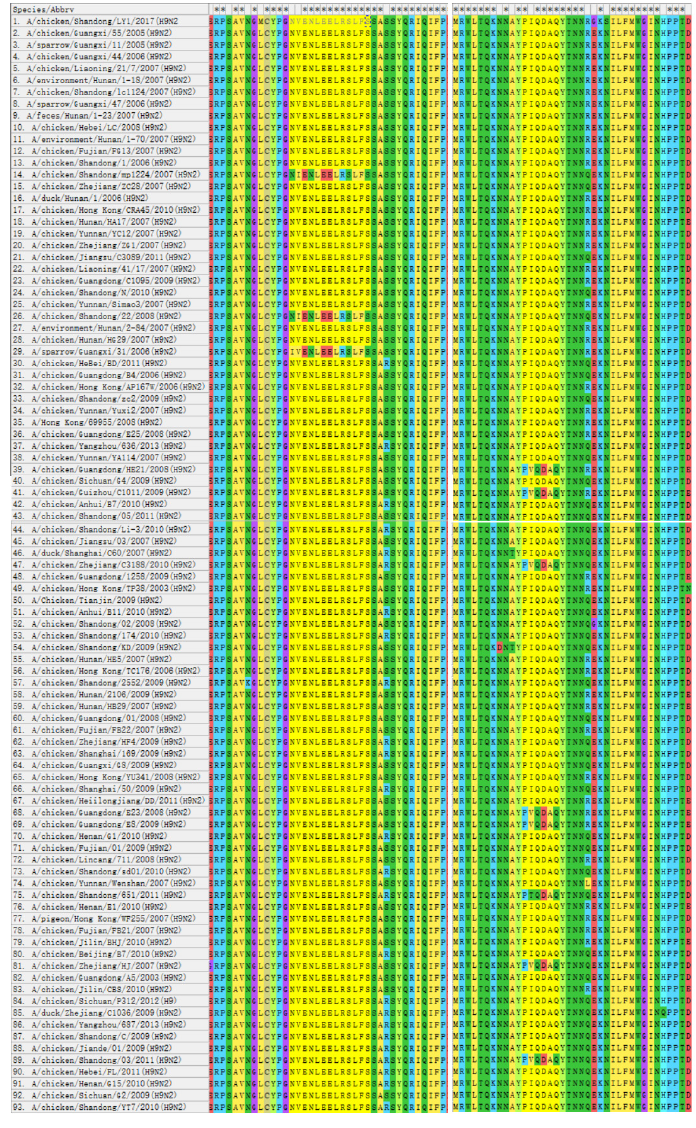
Figure 5. Antigenic epitope motifs were aligned with 93 AIV strains. Homology analysis of the selected sequences was performed by the software MEGA-X in 93 strains. The information for 93 strains H9N2 AIV was showed in Table